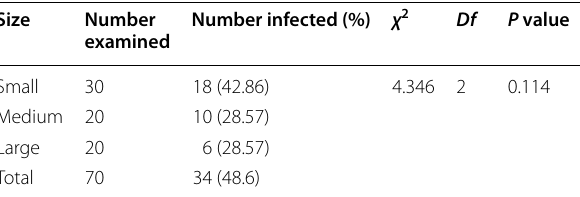
Table 2 Prevalence of Archachatina marginata infected with A. cantonensis by size